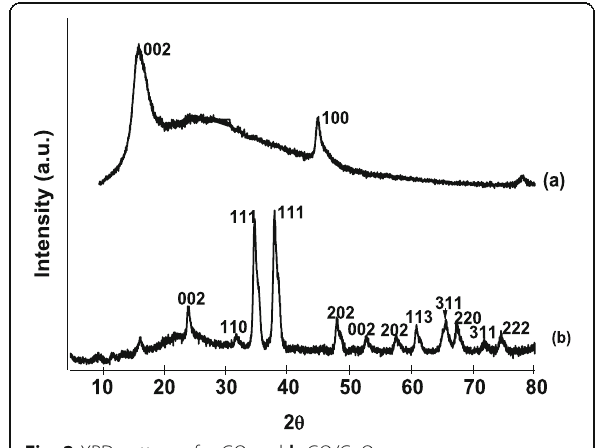
Fig. 2 XRD pattern of a GO and b